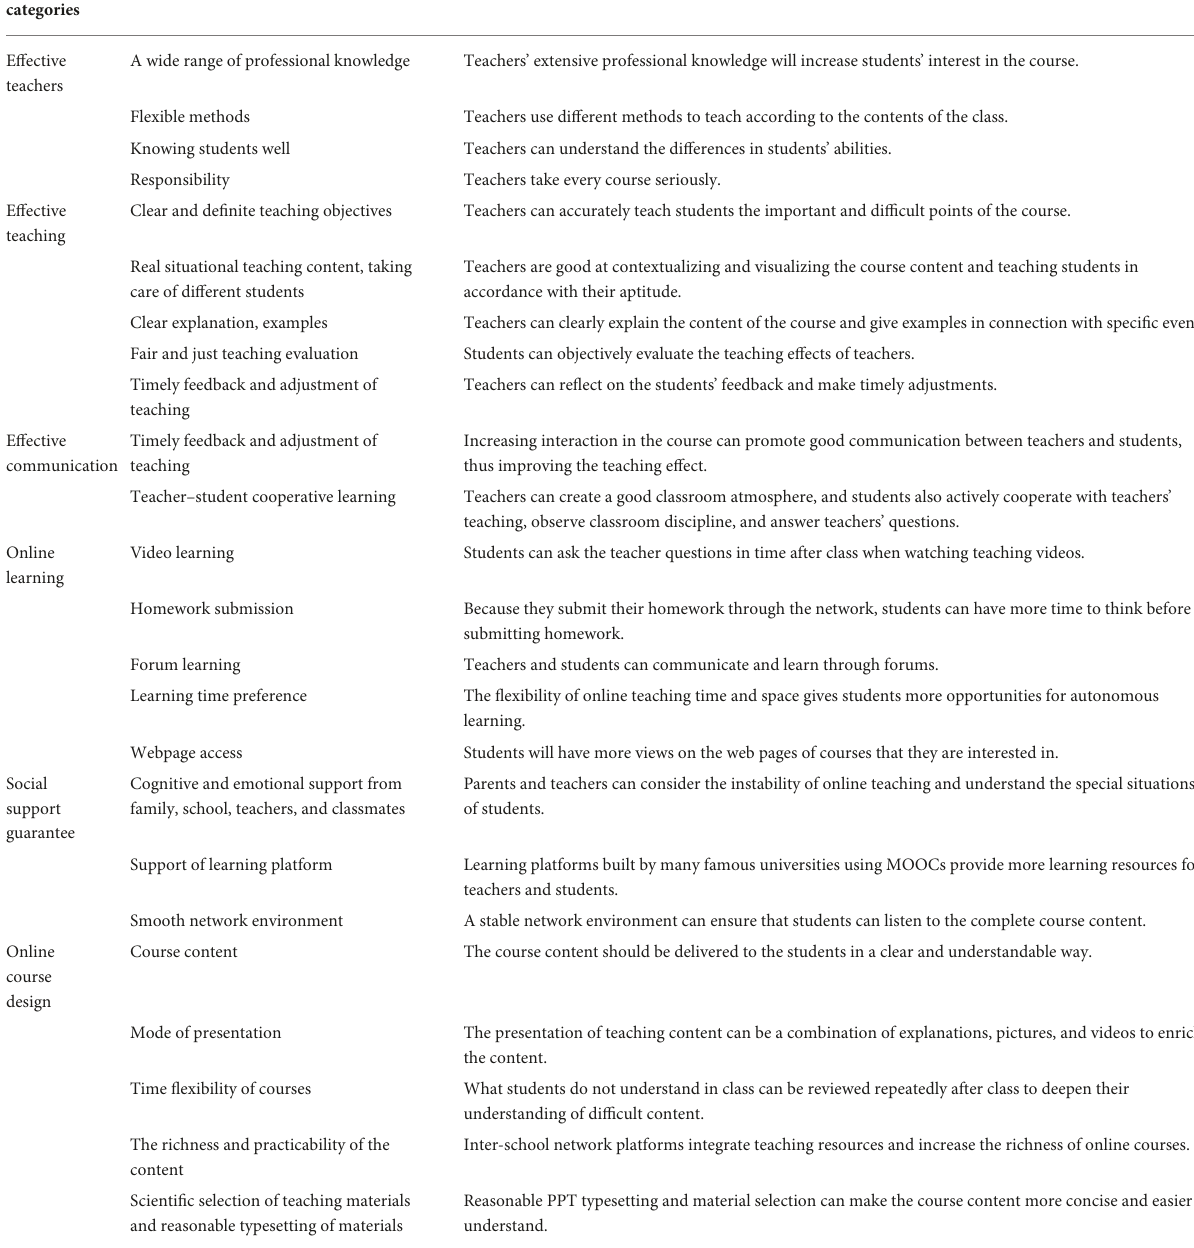
TABLE 4 Main categories formed by principal axis